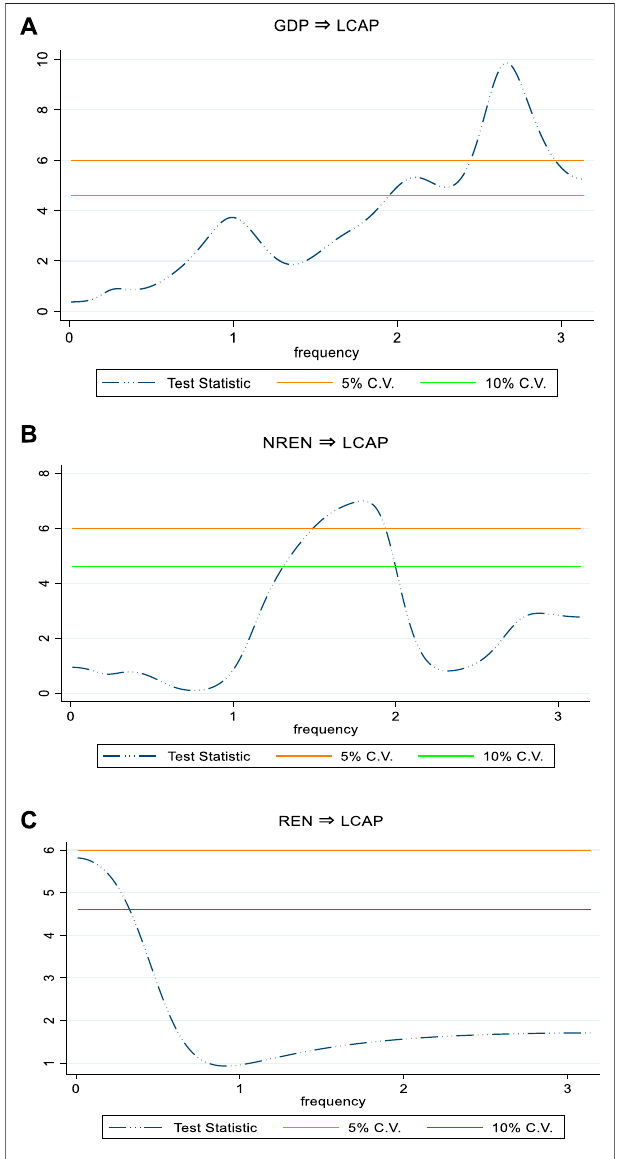
FIGURE 5 | (A) Spectral BC causality from GDP to LCAP. (B) Spectral BC causality from NREN to LCAP. (C) Spectral BC causality from REN to LCAP. (D) Spectral BC causality from FGLO to LCAP. (E) Spectral BC causality from URB to LCAP.